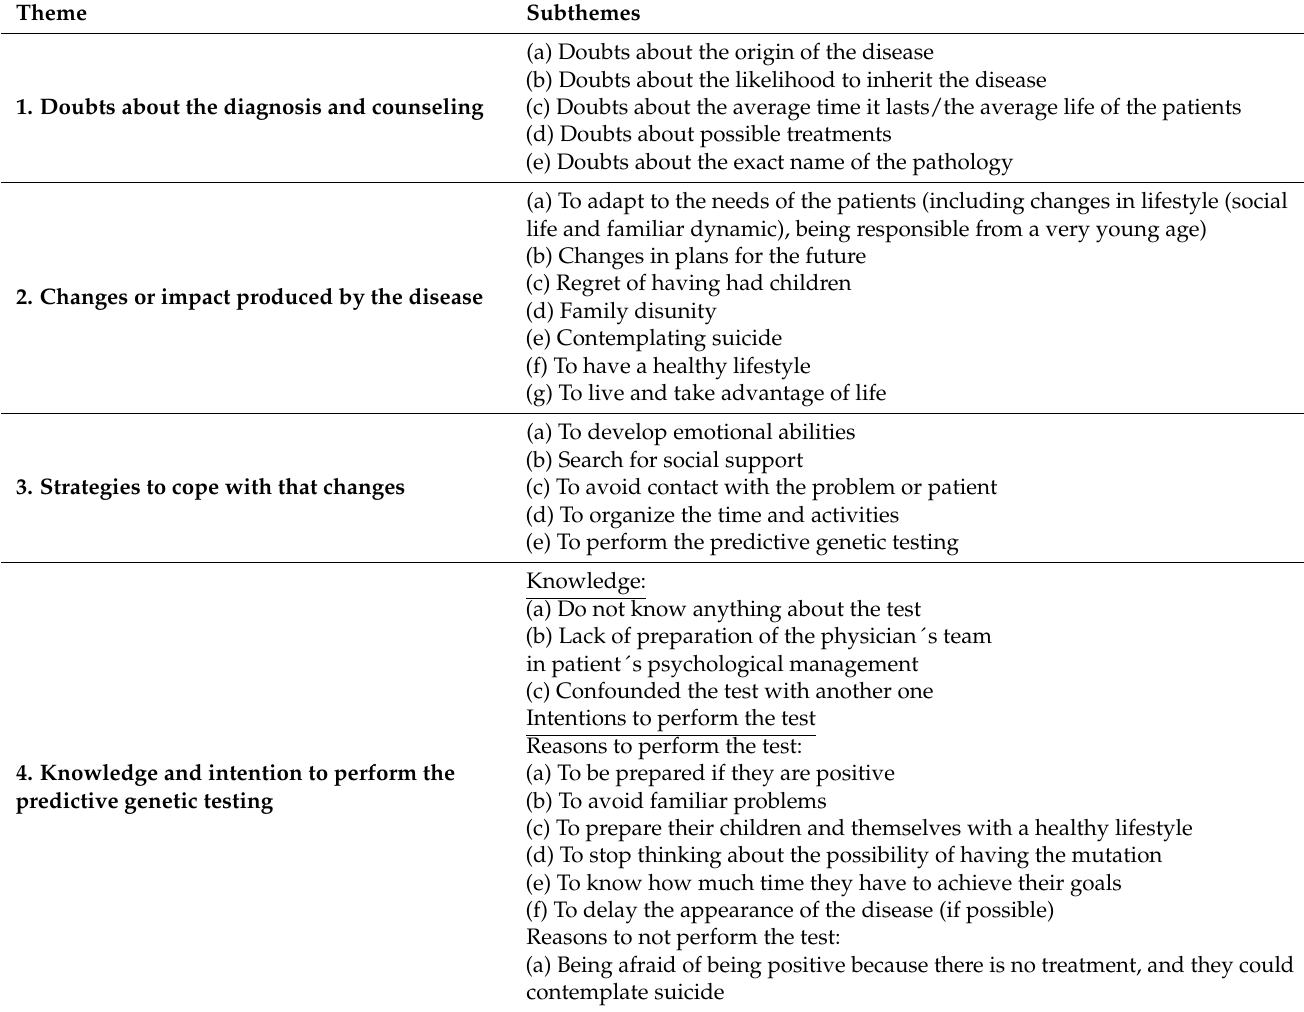
Table 1. Themes and subthemes of the qualitative